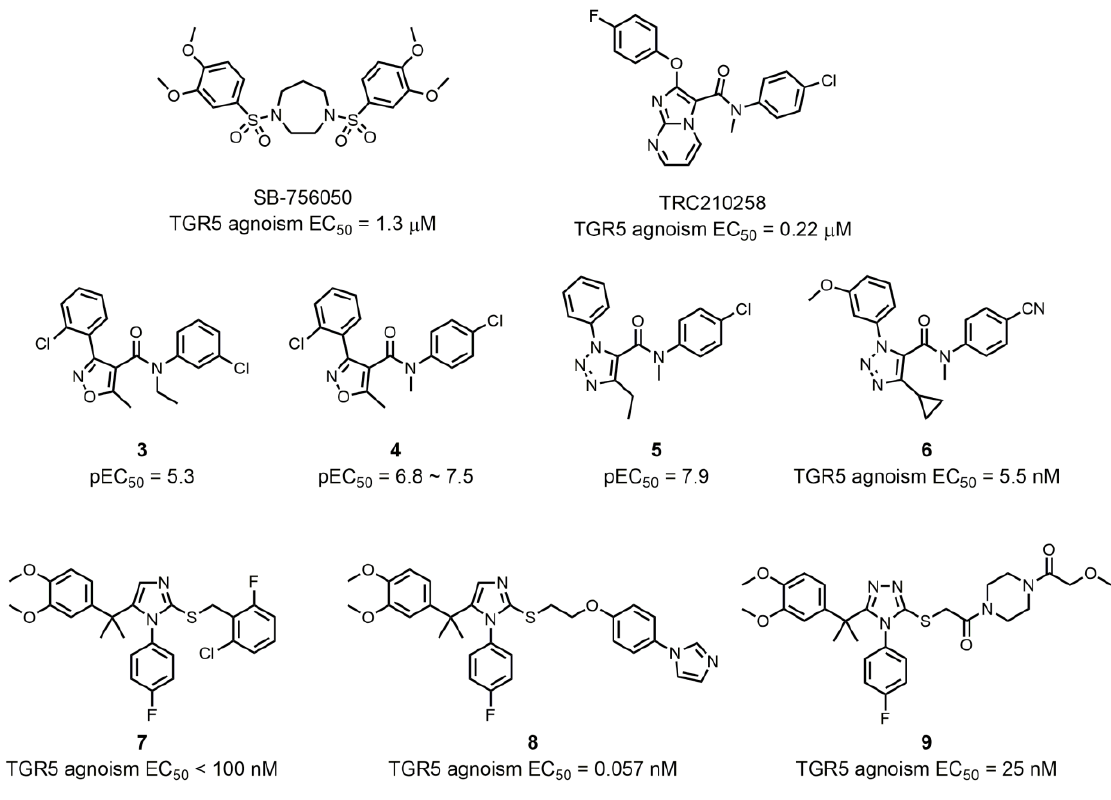
FIGURE 5: Synthetic nonsteroidal TGR5